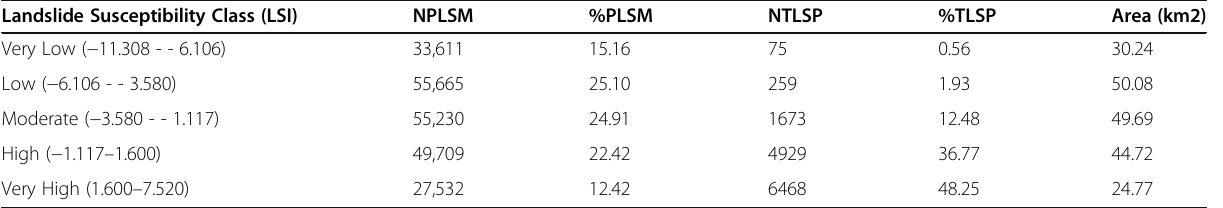
Table 2 The relation between training landslides and landslide susceptibility classes Landslide Susceptibility Class (LSI)